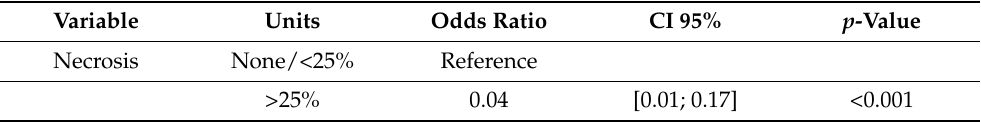
Table 3. Multivariate analysis for IDH